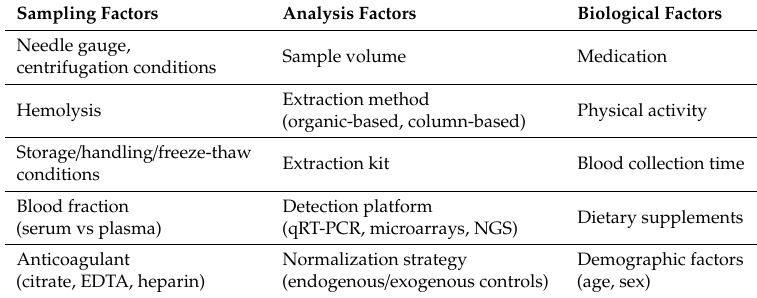
Table 5. Common factors a ff ecting the evaluation of circulating miRNAs as biomarkers for cardiovascular